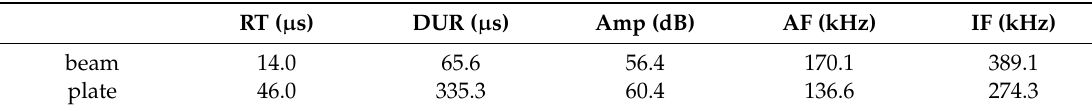
Table 2. Basic waveform descriptors of cracking signals in beam and plate geometries.